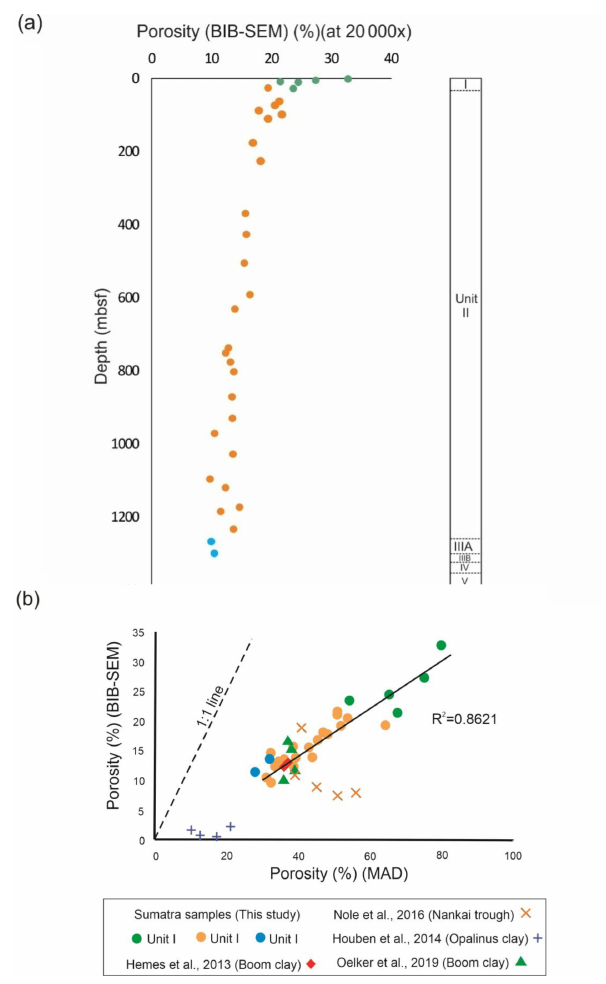
Figure 3. Porosity data for Units I (green dots), II (orange dots), and IIIA (blue dots). (a) BIB–SEM porosity – depth plot; (b) BIB–SEM porosity vs. MAD porosity. Note the linear relationship that inter- sects the origin. Data reported by Hemes et al. (2013), Houben et al. (2014), and Oelker et al. (2019) follow a similar trend. However, data estimated from Nole et al. (2016) deviate from the